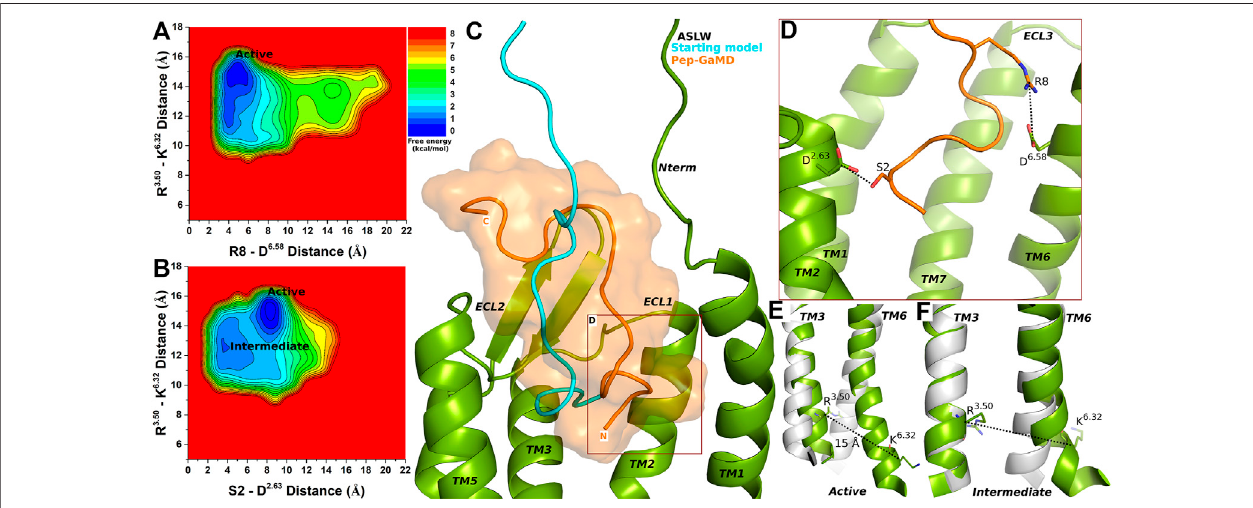
FIGURE 3 | Super agonist ASLW bound CXCR4 sampled Active and Intermediate low-energy conformational states. (A – B) Free energy pro fi les of CXCR4-ASLW interactions calculated regarding the distance between the C α atoms of R 3.50 and K 6.32 and (A) distance between charge centers of peptide residue R8 (the CZ atom) and receptor residue D 6.58 (the CG atom), (B) distance between charge centers of peptide residue S2 (the OG atom) and receptor residue D 2.63 (the CG atom). (C) Comparisonofthetop-rankedstructuralclusterofthesuperagonistASLWobtainedfromPep-GaMDsimulations(orangecartoon)withthestartingcomputational model (cyan cartoon). (D) Important residue interactions between the peptide (orange sticks) and receptor (green sticks) observed in the Pep-GaMD simulations. (E – F) The TM3-TM6 distance between the C α atoms of R 3.50 and K 6.32 as observed in the (E) Active and the (F) Intermediate